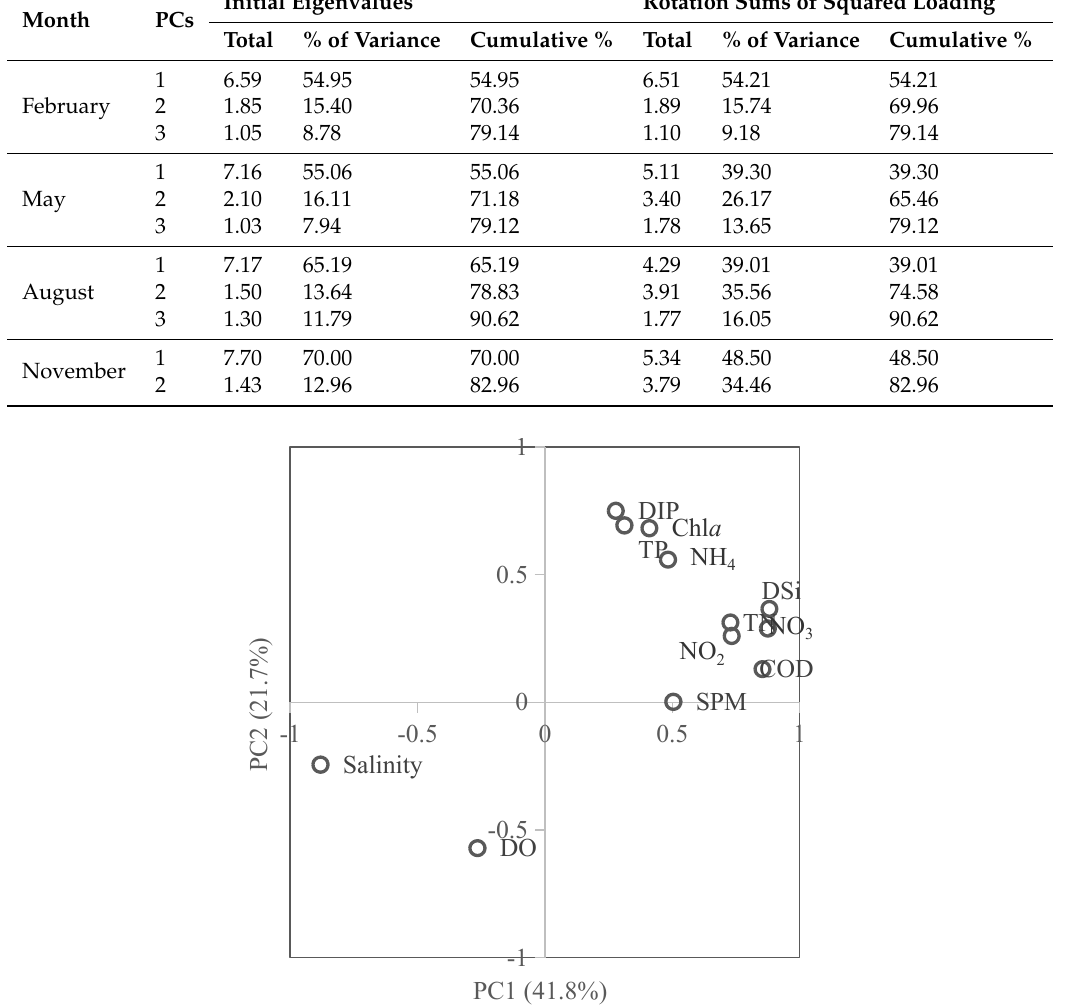
Figure 8. Biological response (in terms of chlorophyll a ) to nutrients (N, P, Si) and hydrology in the Pearl River